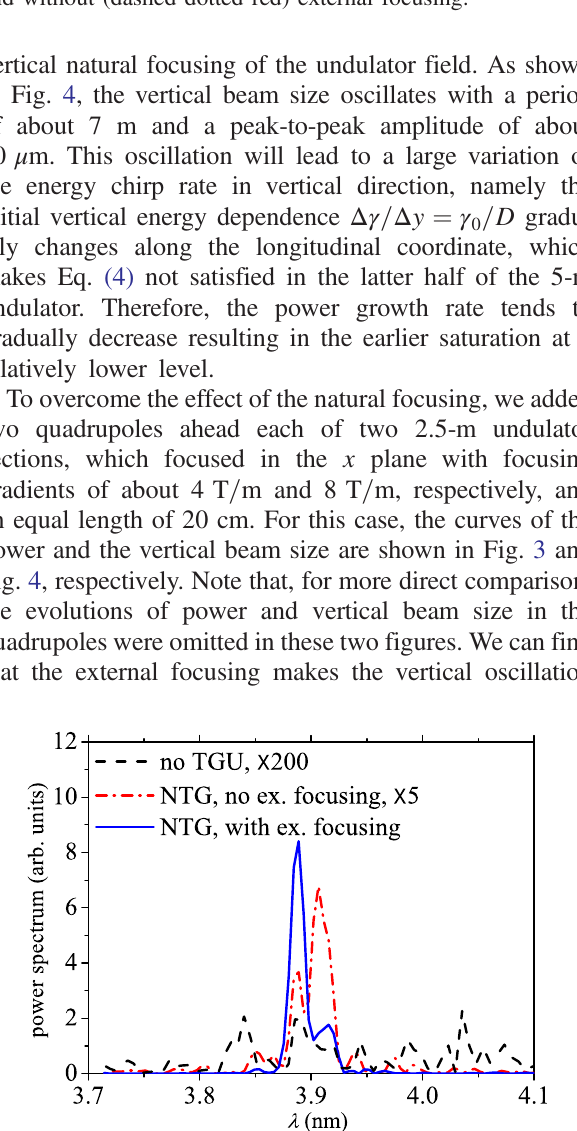
FIG. 4. The evolution of vertical beam size along the 5-m undulator for using natural transverse gradient with (solid blue) and without (dashed dotted red) external focusing.